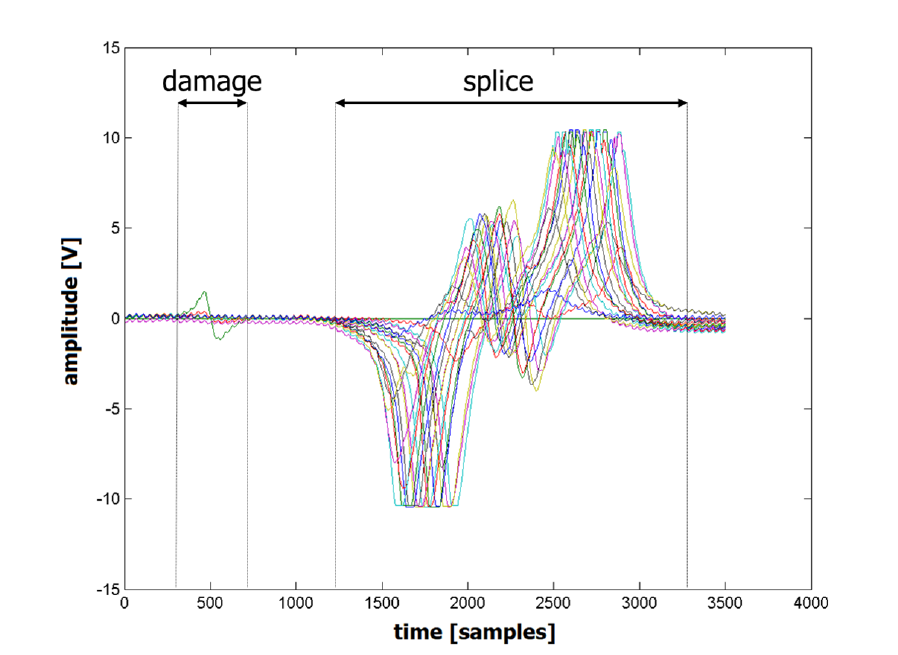
Figure 7. The raw magnetic field variations recorded for a belt with damage and